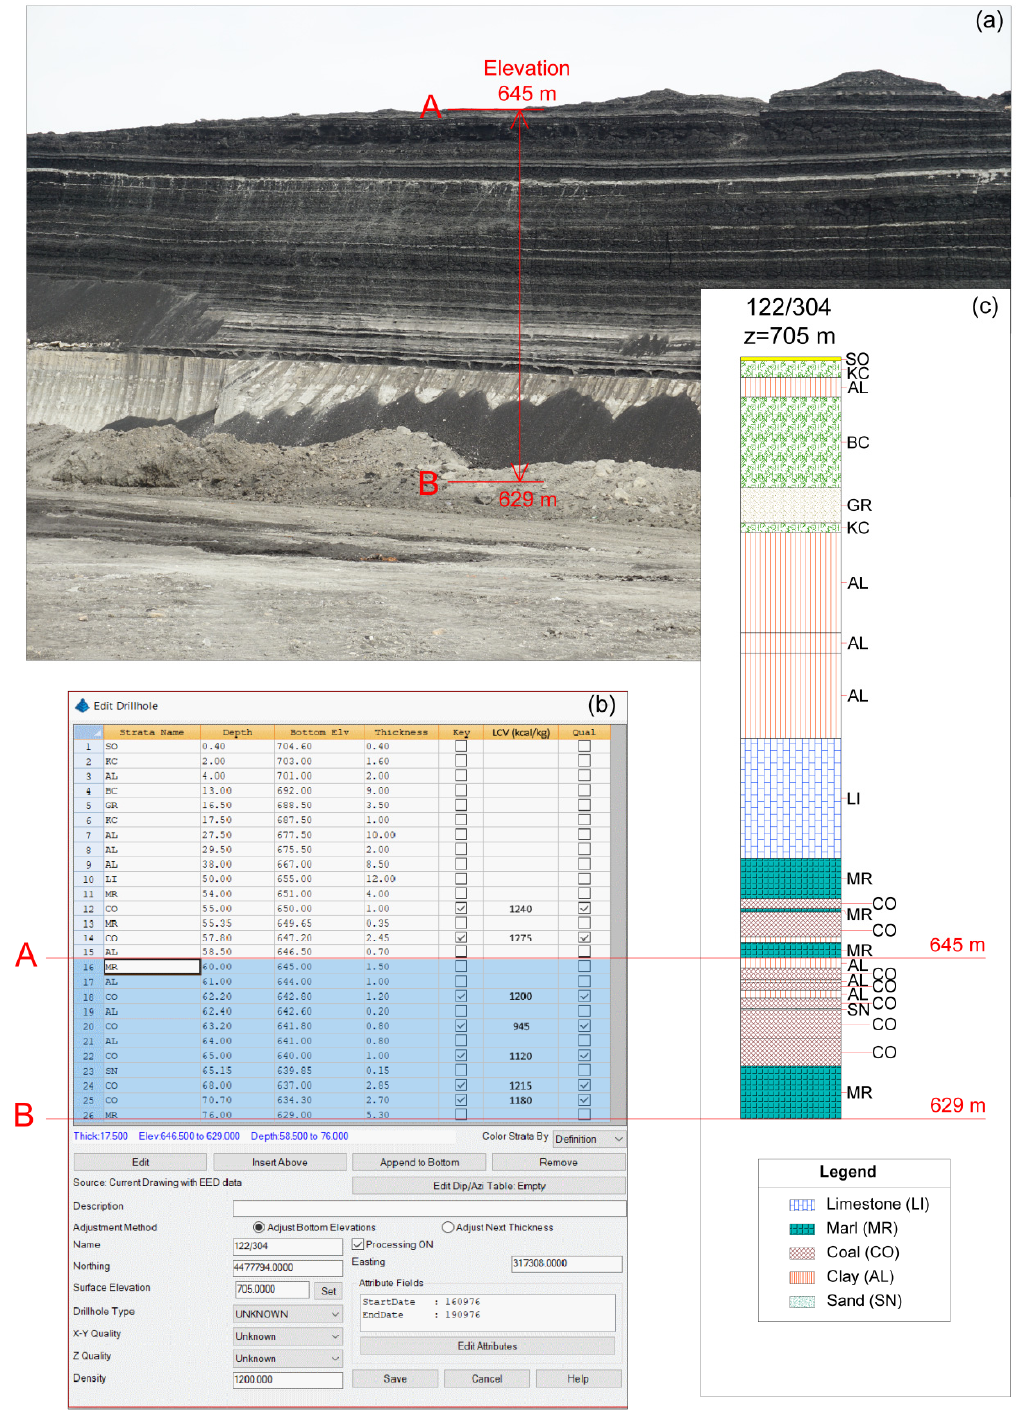
Figure 6. Variation of Lower Calorific Value (LCV) of lignite seams separated by waste seams (clay, sand, and marl), ( a ) typical multi-seam bench of the South Field mine (AB: part of the drill-hole 122 / 304), ( b ) analytical data of the drill-hole 122 / 304, ( c ) waste and coal seams of the drill-hole 122 / 304 (location of the drill-hole is presented in Figure 3)